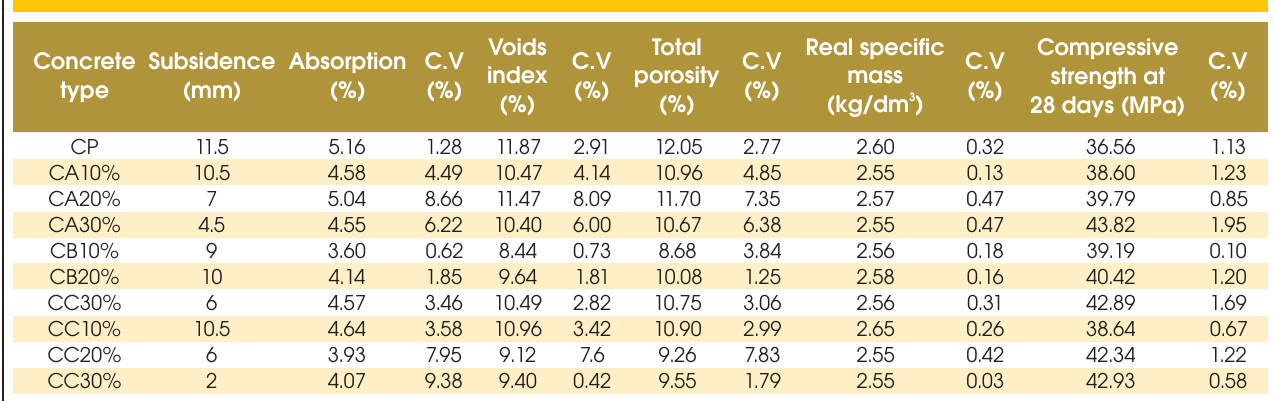
Table 6 – Results of the key properties that influence the mechanical behavior of concrete with addition of SBA